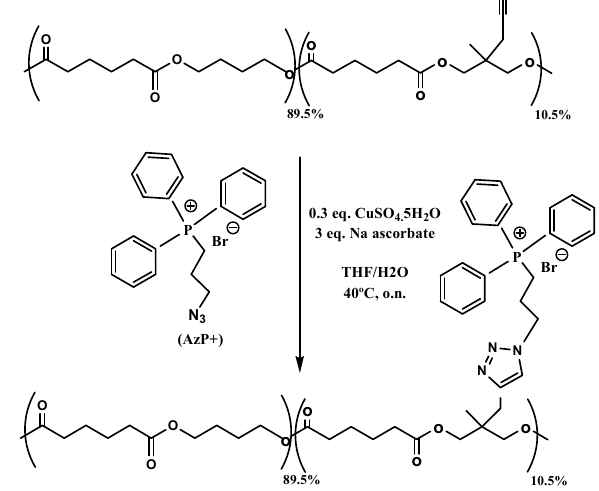
Figure 14. ( a ) Schematic representation of the preparation of micropatterned PBS surface. ( b ) SEM (left) and immunostaining (right) of human adipose stem cells (hASCs) cultured onto micropatterned PBS surfaces. Reprinted with permission from [180]. Copyright (2010), by permission of Elsevier Science